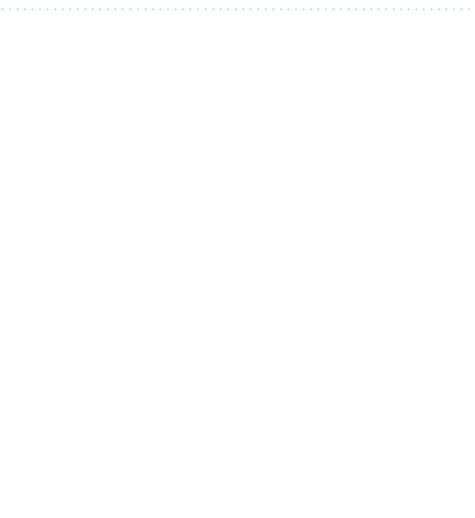
Table 3. List of the wrong initial